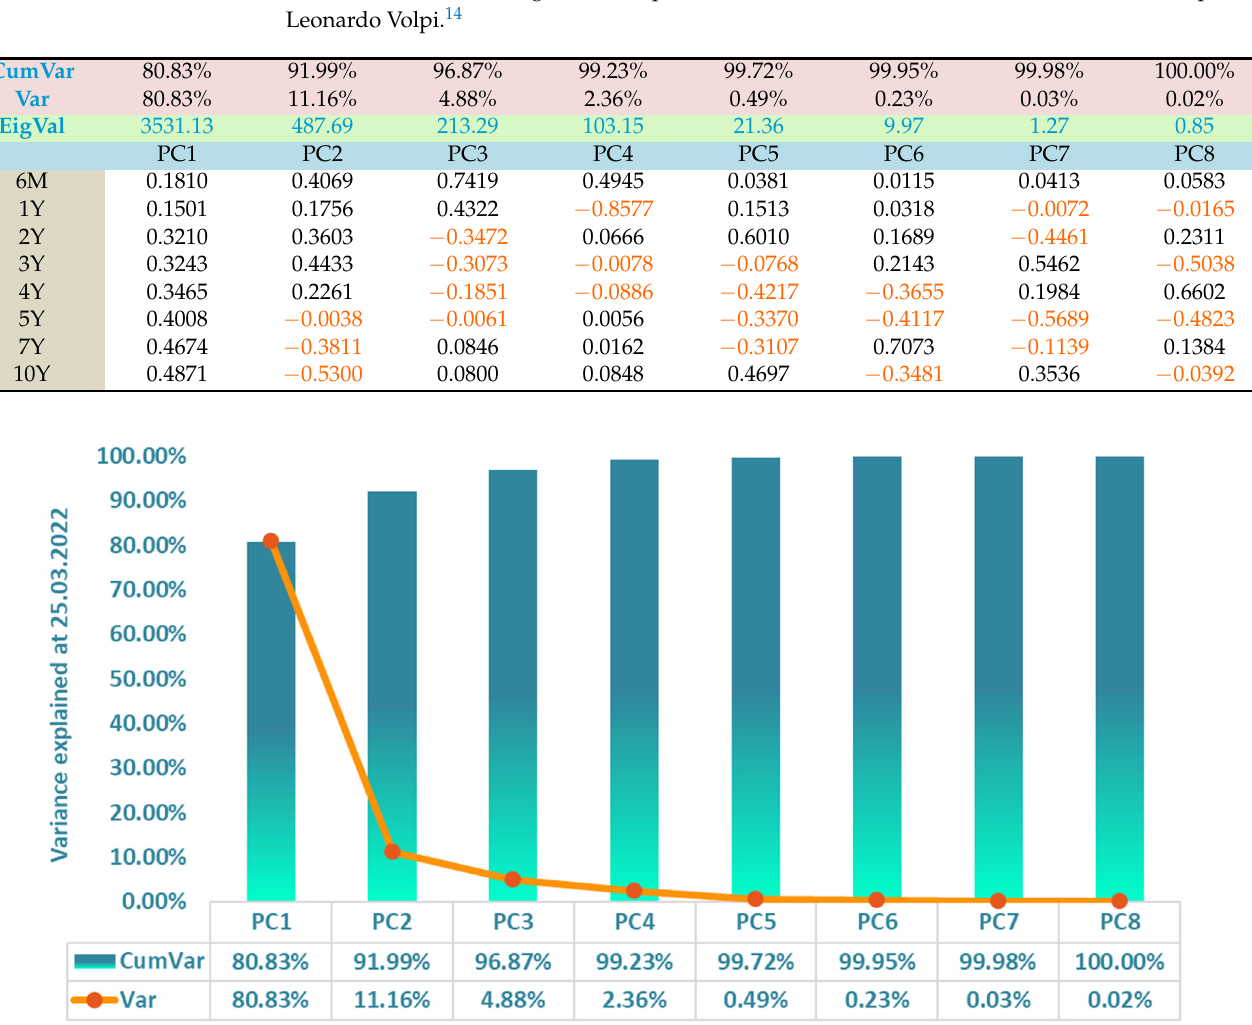
Figure 3. Yield curve variability explained by principal components on 25 March 2022. Source: Bloomberg, own computation of PCs with the use of a VBA add-in developed by Leonardo Volpi.